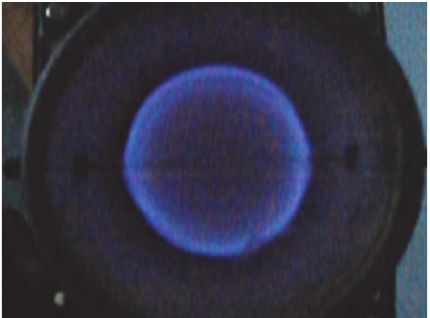
Figure 3: Photo of flame ethanol 95.5% v; at 𝜙 = 1 after 23.81